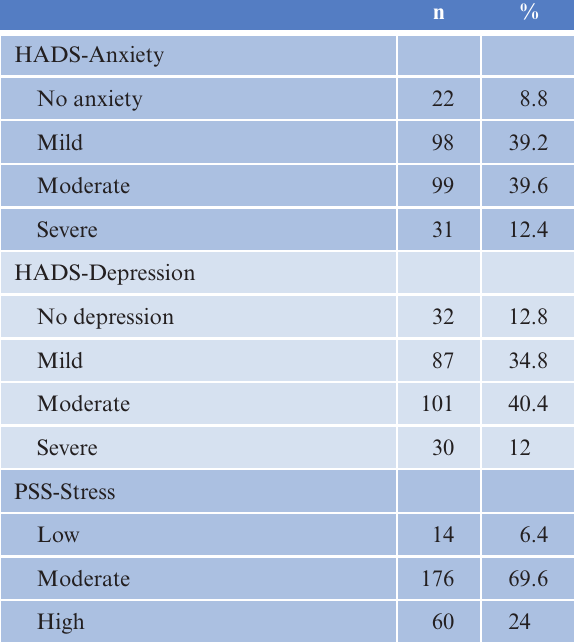
Table 2 : Anxiety, depression, and perceived stress in kidney cancer patients ( n =